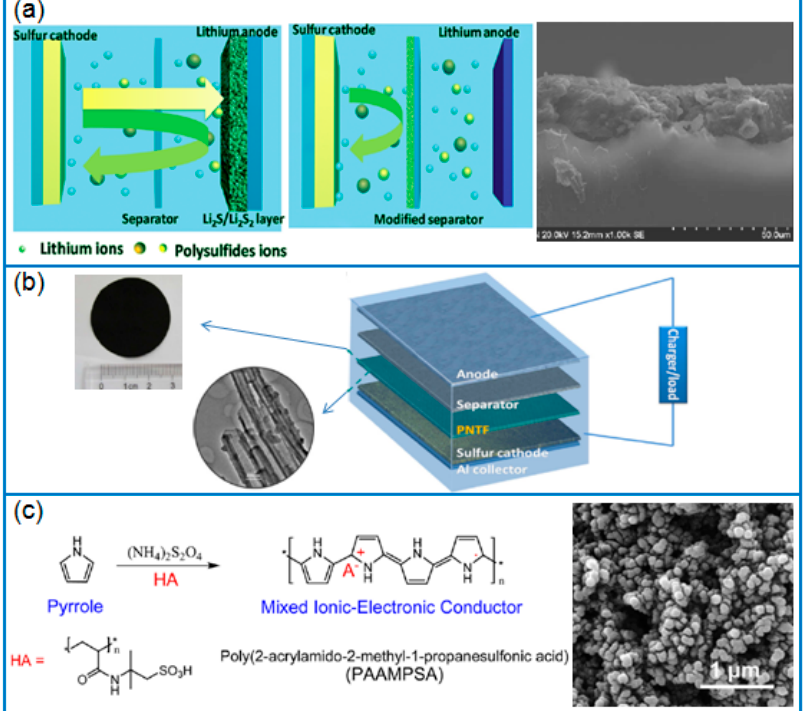
Figure 6. ( a ) The difference of common separator and the modified separator, and corresponding PPy nanotubes modified separator [80]; ( b ) The configuration of Li-S battery with PNTF and corresponding images of PPy nanotube film [81]; ( c ) The synthesis of PAAMPSA-doped PPy mixed MIEC and the corresponding SEM image [82].